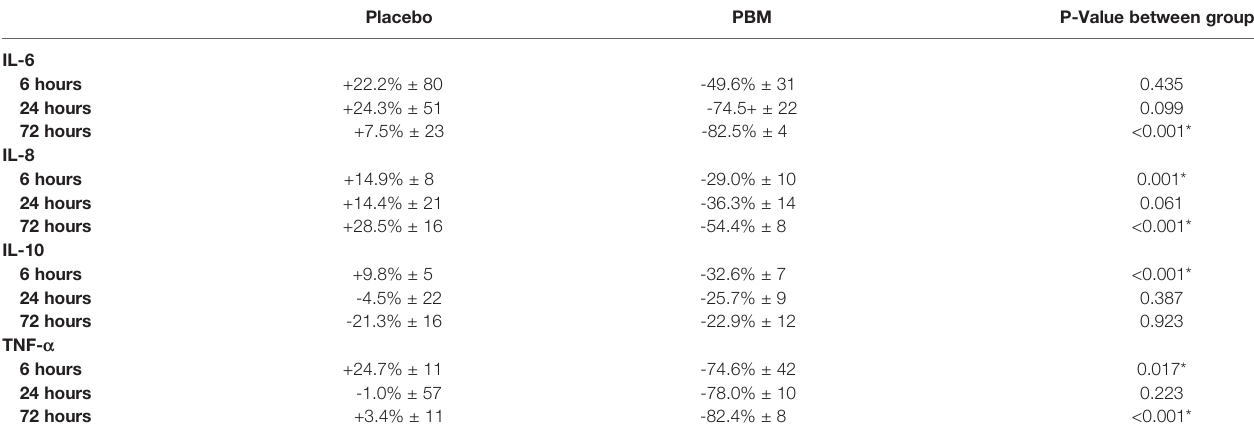
TABLE 3 | Percentage of change in secretion levels of IL-6, IL-8, IL-10 and TNF-alpha, after 6, 24 and 72h of PBM or Placebo (based on normalized values to T=0h). Placebo